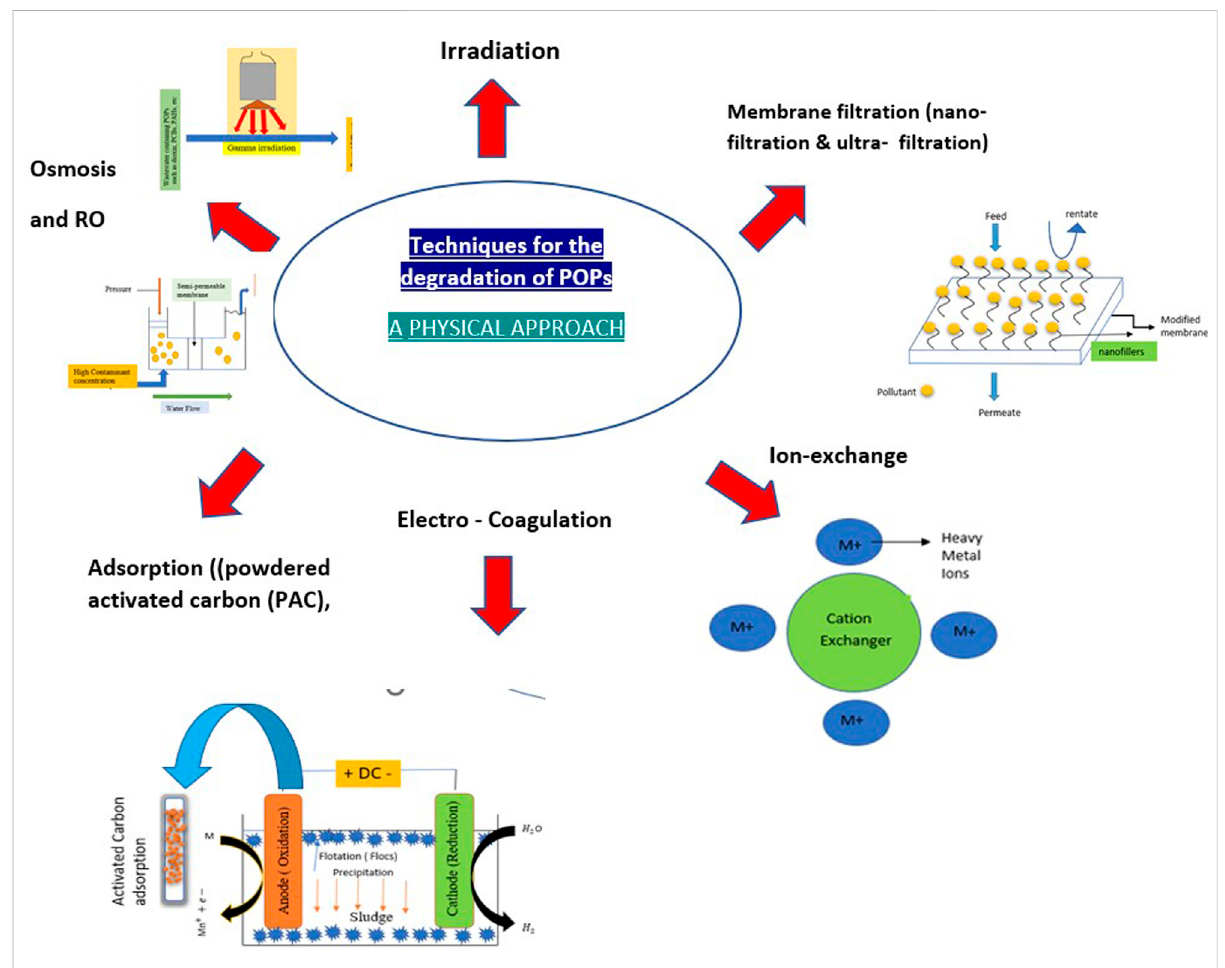
FIGURE 1 Physical techniques used for the degradation of persistent organic